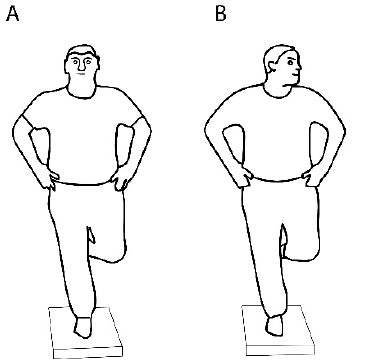
Figure 1. Stances during balance assessment: forward facing ( A ) and neck rotated 90° ( B ) balance tasks.